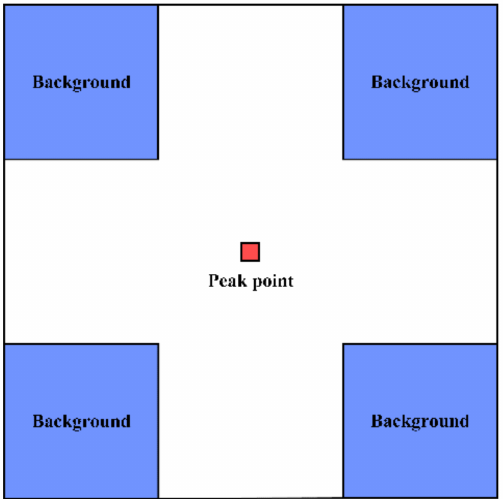
Figure 5. SCR calculation region. The red pixel represents the peak point, and the blue pixels represent the clutter